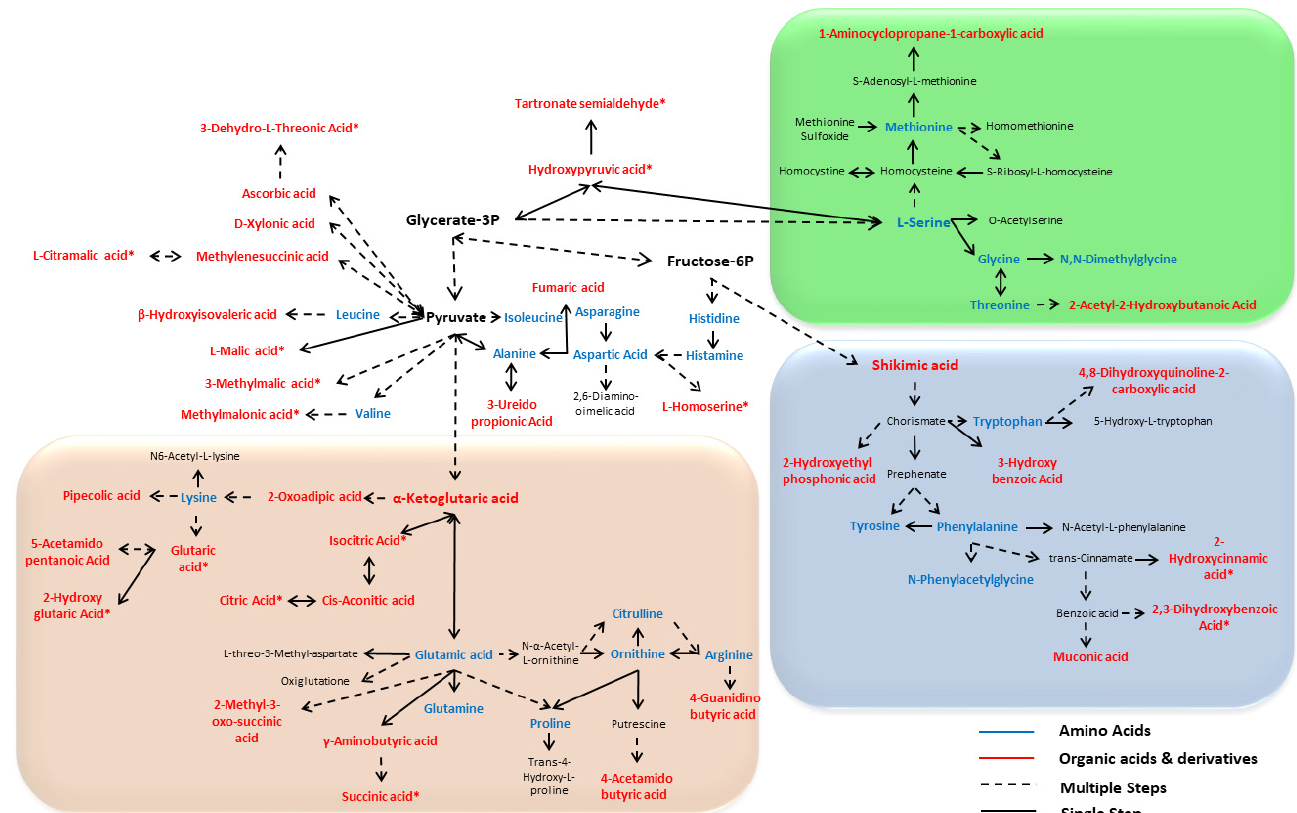
Figure 3. Comprehensive amino acid and organic acid biosynthesis pathway. The blue color compounds represent amino acids whereas the red color compounds represent organic acids that were identified by LC–MS/MS method in sugarcane rinds. All the colored compounds are identified in this study in sugarcane rind whereas the black colored compounds are shown only for describing the sequence and better understanding of metabolic pathway. Dotted lines indicate several enzymatic steps whereas plain lines indicate single steps. The light green, purple, and pink color signify the three major organic acid and amino acid biosynthesis pathways. KEGG plant metabolism (https://www.genome.jp/kegg/pathway.html#metabolism; accessed on 25 November 2021) was used to construct this